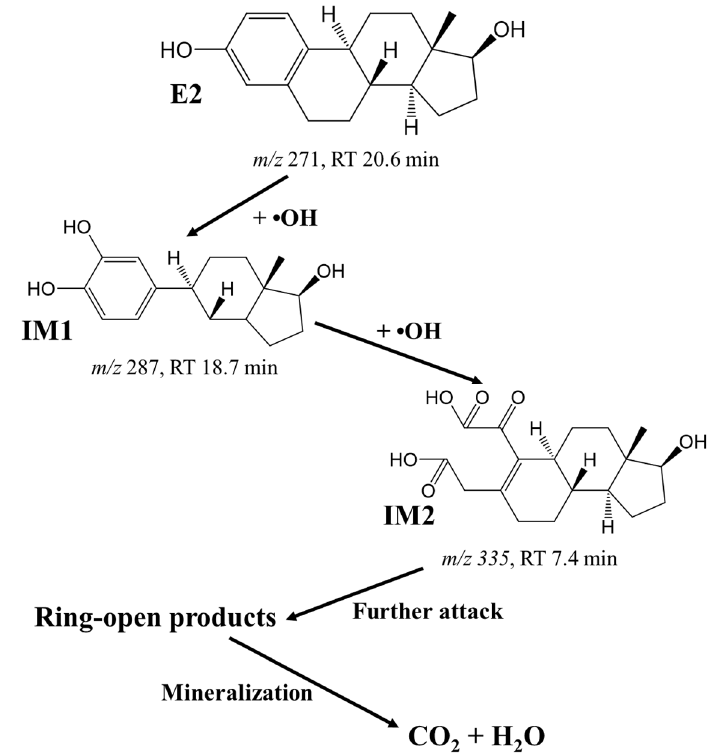
Figure 7. Photo-degradation pathway of adsorbed E2 by AC and TNTs@AC. (Initial E2 concentration = 0.5 or 1.0 mg / L, material dosage = 0.5 g / L, temperature = 25 ± 0.2 ◦ C, volume of solution = 40 mL, solution pH = 7.0 ± 0.2).